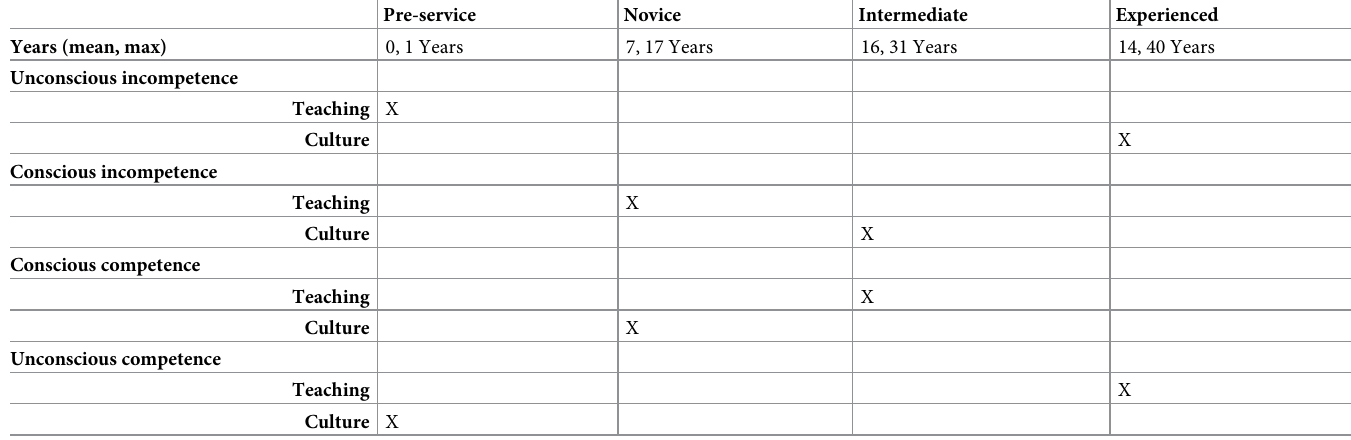
Table 1. Competence, culture, and